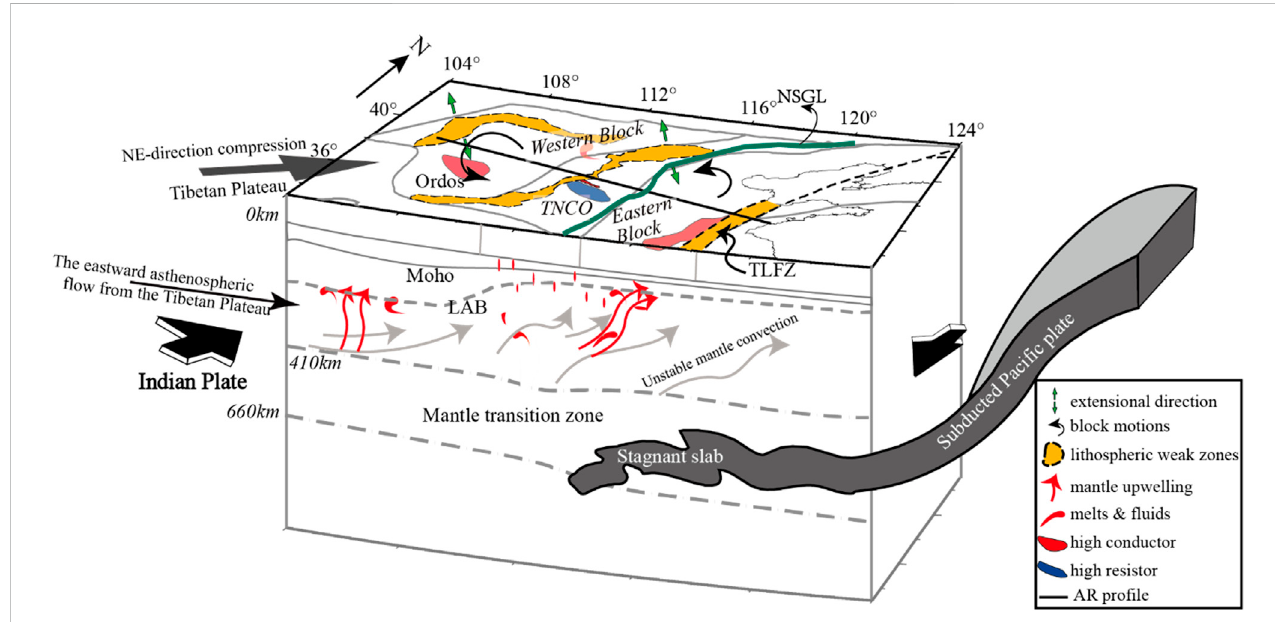
FIGURE 9 A cartoon diagram of the deep process of the destruction of the North China Craton modi fi ed from (Xu et al., 2018). TNCO: Trans-North China Orogen, TLFZ: Tan-Lu Fault Zone, and NSGL: North-South Gravity lineament after (Deng et al.,